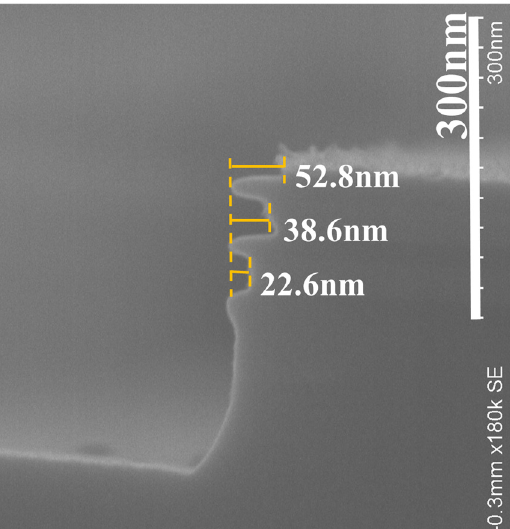
Figure 10. The SEM cross–section images of Sample V after digital etching with 31.5% HNO 3 -dBOE q-ALE for 100 cycles.